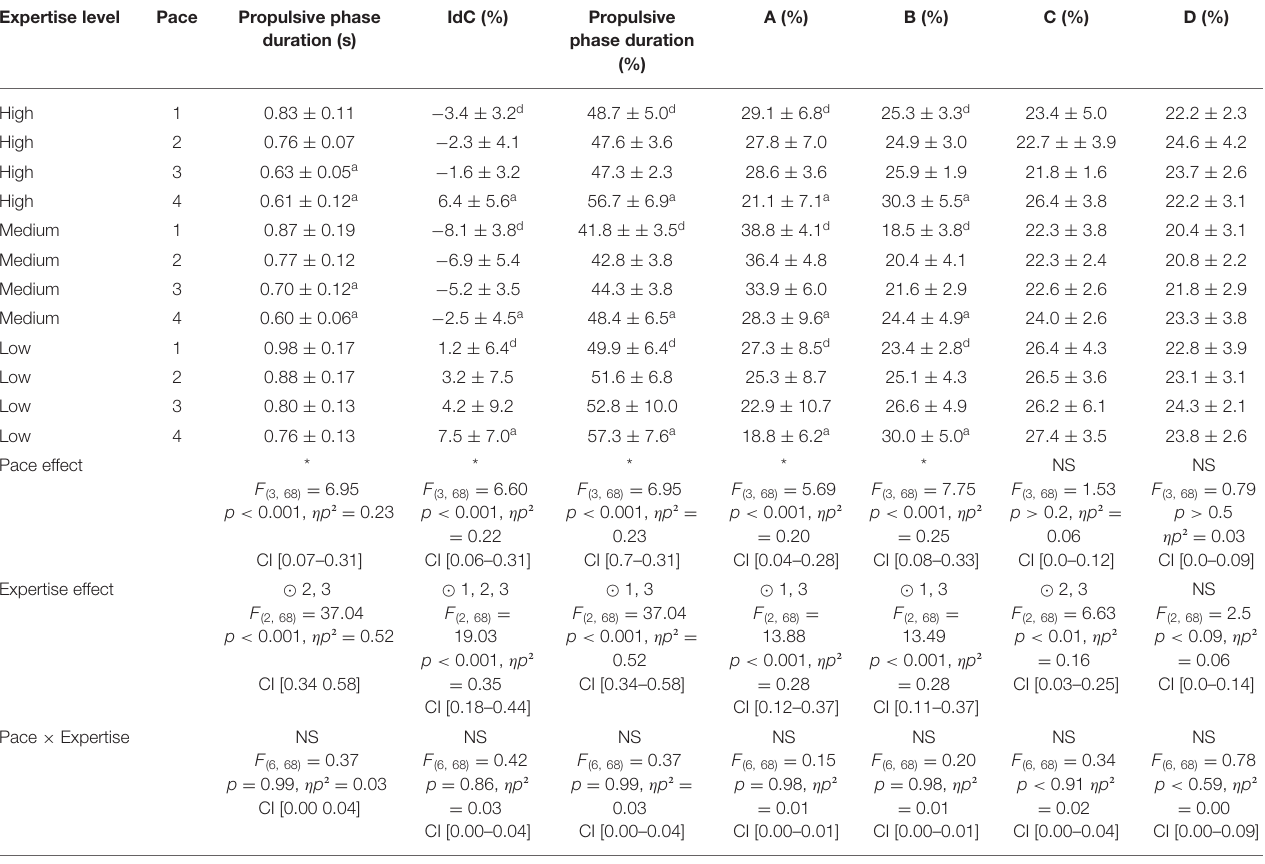
TABLE 4 | Coordination parameters according to pace and expertise level. Expertise